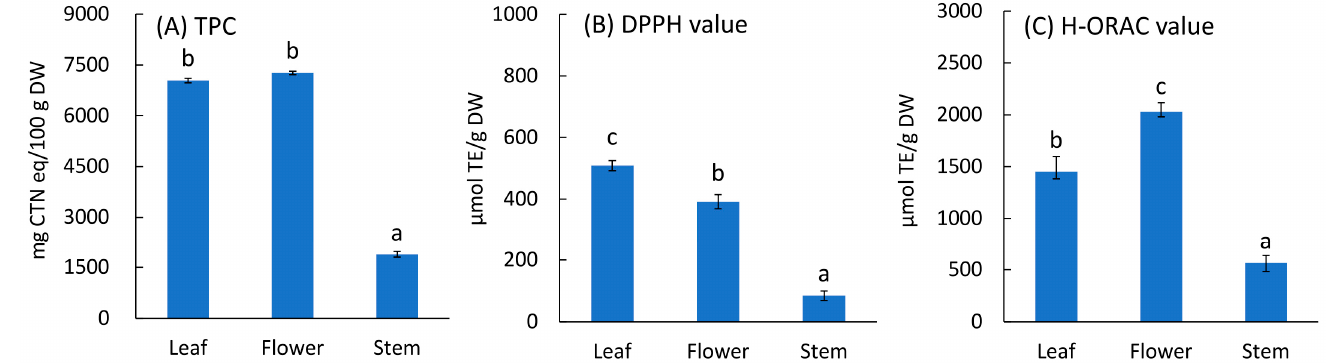
Figure 2. TPC, DPPH, and H-ORAC values of parts of Ocimum basilicum cv. ‘Genovese’. TPC: Total polyphenol content, DPPH value: DPPH radical scavenging activity value, H-ORAC value: Hydrophilic oxygen radical absorbance capacity value. The values are expressed as the standard reagents equivalent per dry weight. The results were obtained using Tukey’s test for multiple comparisons. Different letters indicate signi fi cant di ff erences at p < 0.05. Data are expressed as mean ± SE (n = 6).